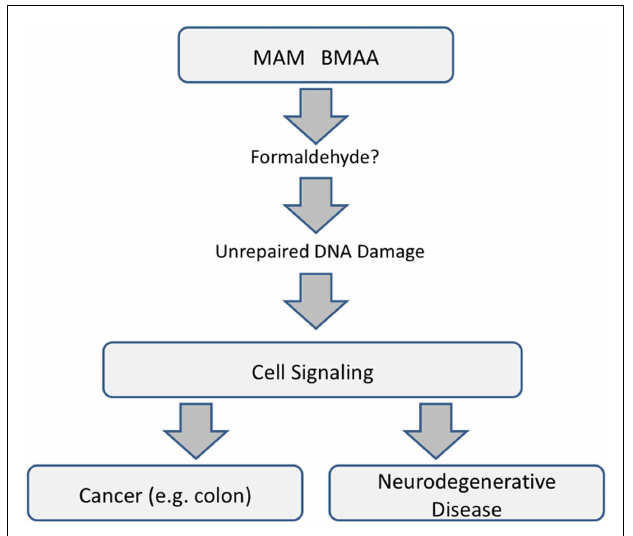
FIGURE 4 | Common pathways underlying cancer and neurodegenerative diseases that are mediated by